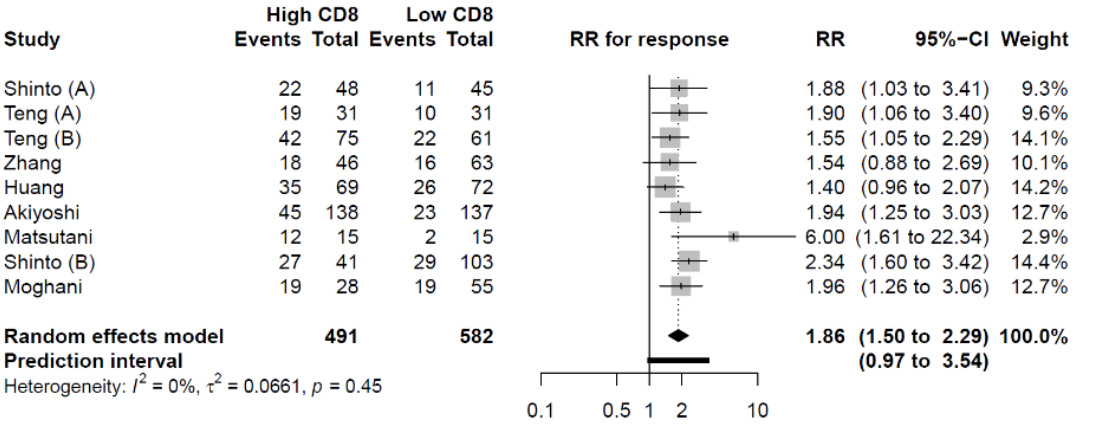
Figure 3. The relationship between CD8 + TILs density and pTR. Patients with high CD8 + TILs density had a significantly increased likelihood of achieving a pTR. RR: Risk Ratio.